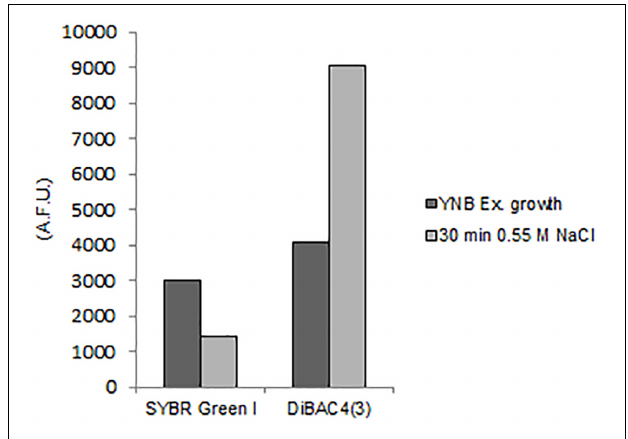
FIGURE 7 | Quantitative analysis of SYBR Green I and DiBAC 4 (3) fluorescences detected by FMC in S. cerevisiae cells after exposure to hyper-osmotic stress (0.55 M NaCl). AFU, Arbitrary Fluorescence